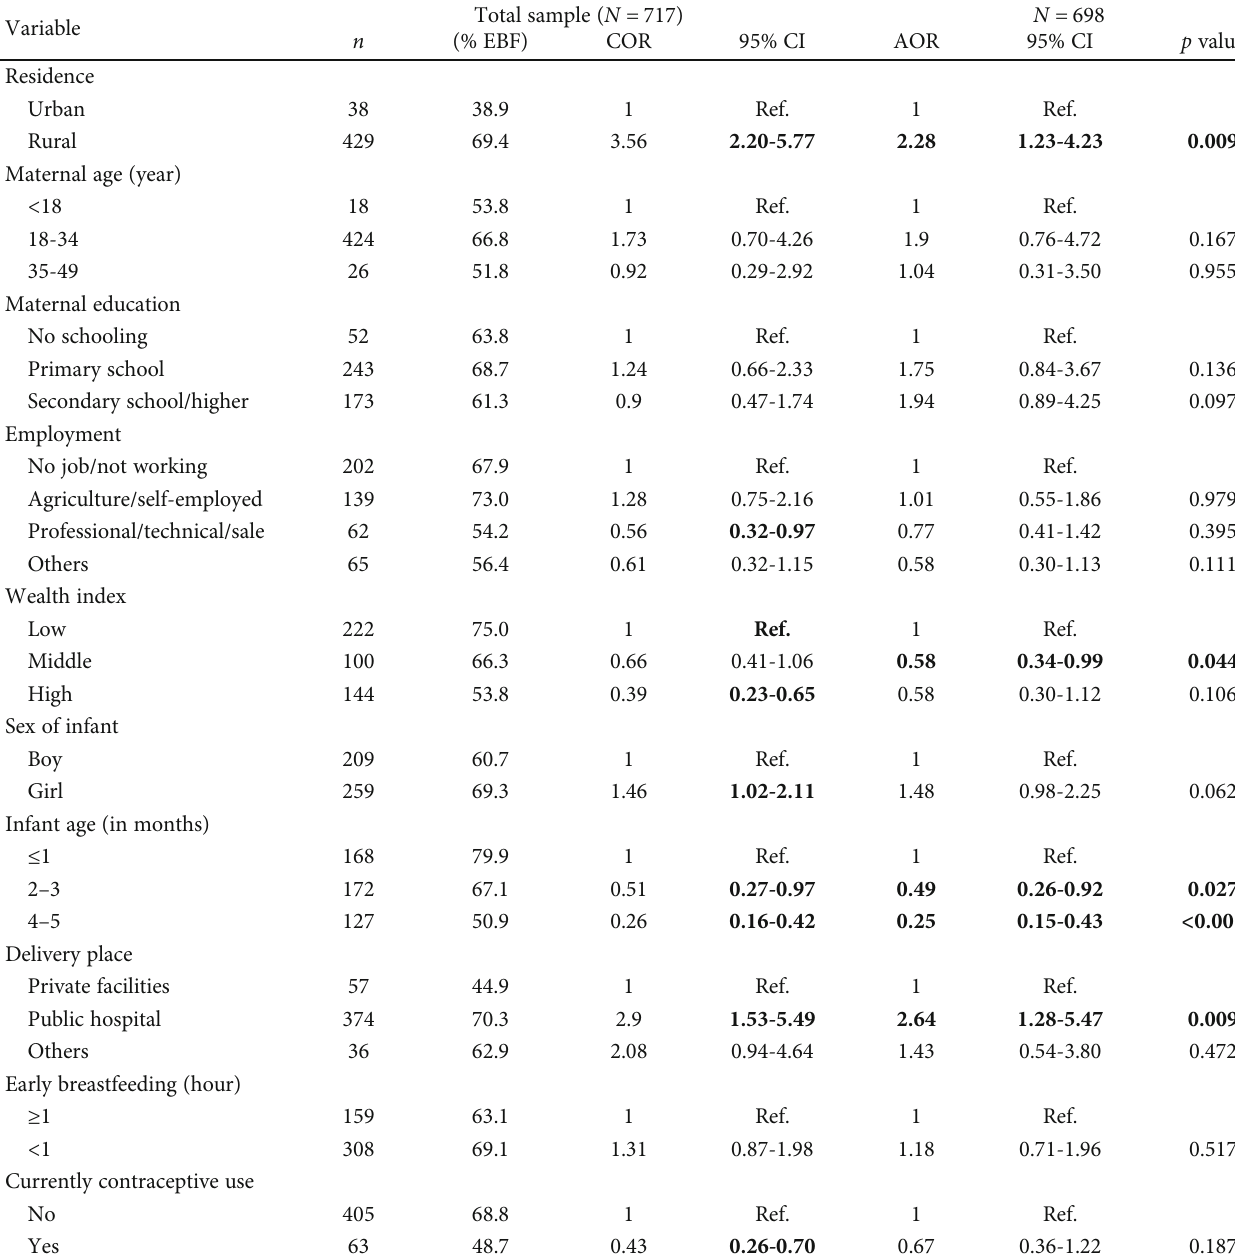
Table 2: Factors associated with EBF among infants aged less than 6